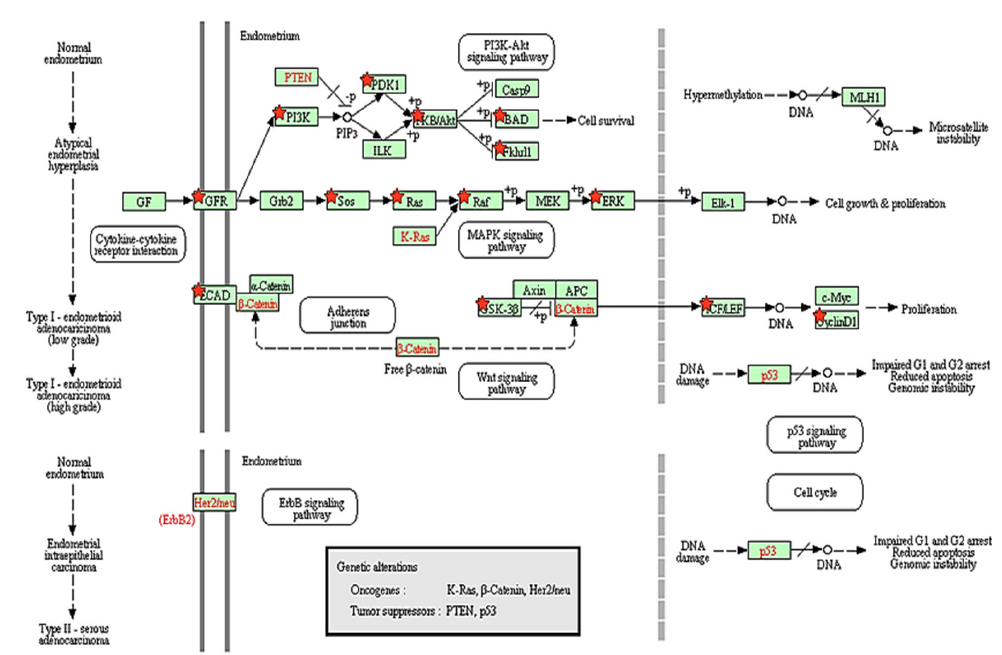
Figure 3. Endometrial cancer pathway obtained from detected DEGs following LPS challenge. Red asterisks (*) show DEGs in our RNASeq reads. The red font in the figure shows tumor suppressor genes.